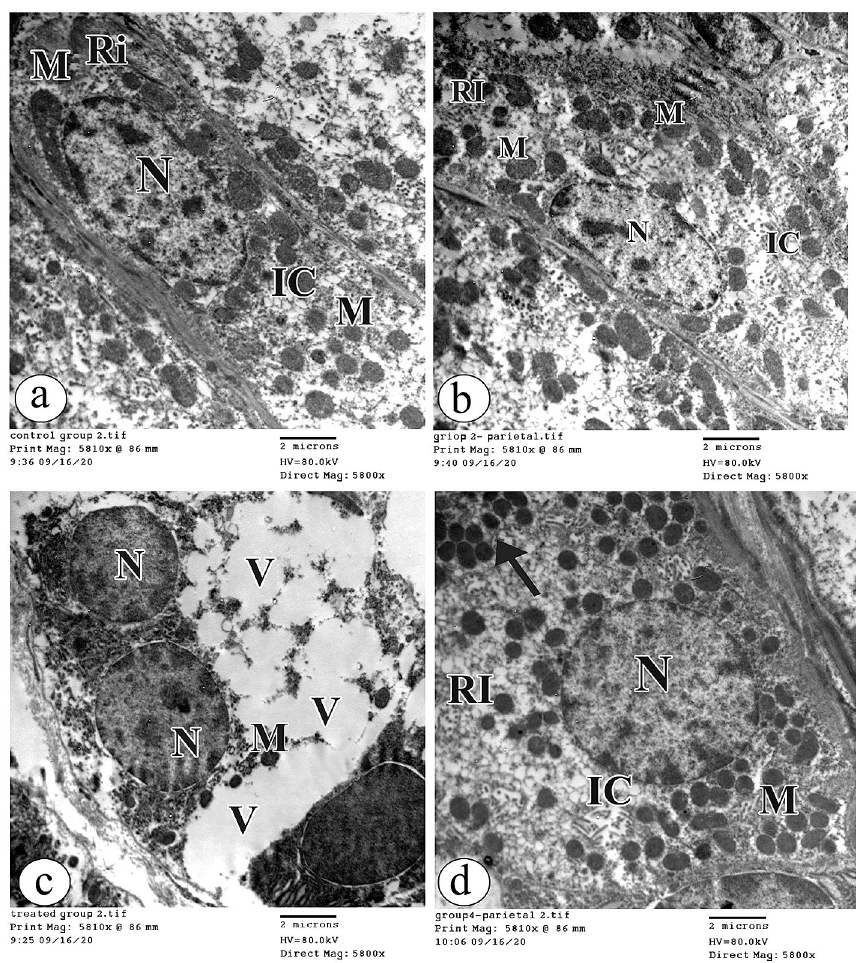
Figure 9. The electron photomicrographs of the parietal cell in ( a ) the group Ӏ showing an oval euchromatic nucleus (N). The cytoplasm contains abundant mitochondria (M), intracellular canaliculi (IC) and free ribosomes (RI). ( b ) the group ӀӀ showing an ultrastructural morphology as in the group Ӏ . ( c ) the group ӀӀӀ showing a marked loss of cell organelles with a vacuolated cytoplasm (V). Few electron dense mitochondria (M) and another destructed one (arrow) are noticed. The euchromatic nucleus (N) is seen. ( d ) the group Ӏ V showing an oval euchromatic nucleus (N). The cytoplasm contains the intracellular canaliculi (IC) and free ribosomes (RI). Some mitochondria (M) appear normal; however, others are electron dense (arrow). (TEM × 5800, Scale bar = 2